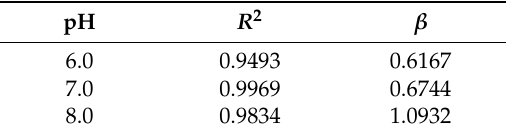
Figure 6. Mean square displacement (MSD) of single HA molecules at different pH values. The data has been fit using the exponential function MSD ∝ t β such that when β = 1, normal diffusion is represented; when β < 1, subdiffusion is represented; and when β > 1, superdiffusion is represented. Individual exponents are presented in Table 2. The legend indicates pH values. Table 2. Individual goodness-of-fit and exponents of the mean square displacement. R 2 is the coefficient of multiple determinations for regression, which ranges from 0 to 1 and measures how close the data are to the fitted regression line and how well the observed outcomes are replicated by the model.